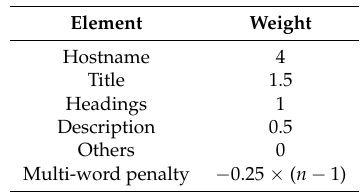
Table 1. The bonus weighting scheme for candidate phrases using WebEmbedRank. n is the number of words in the phrase.